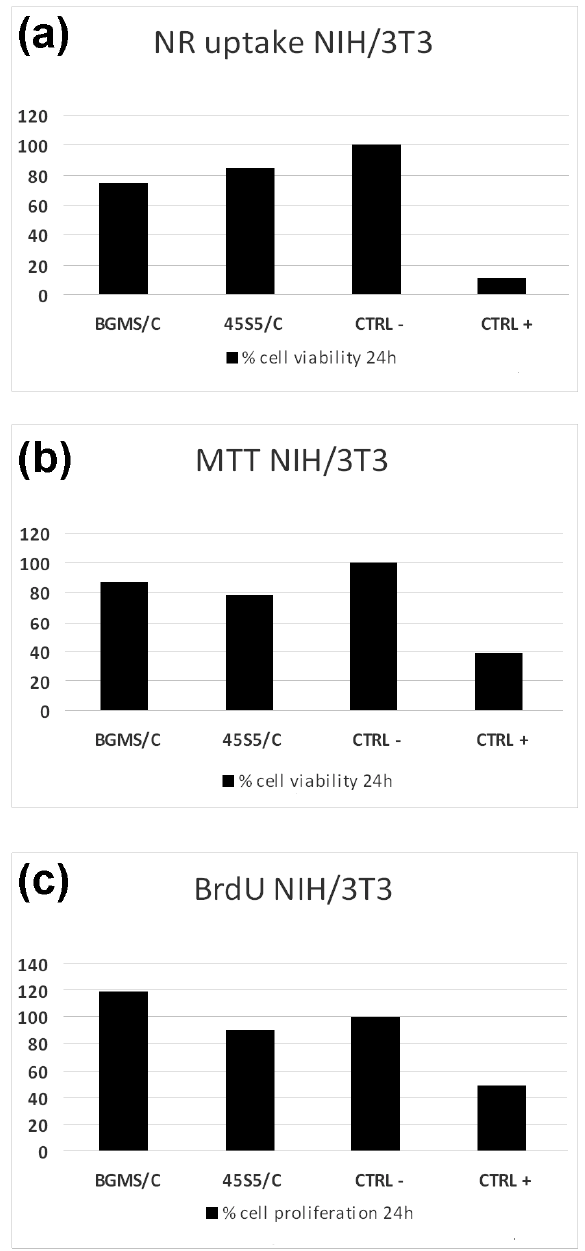
Figure 3. Results of the NR, MTT and BrdU tests for NIH / 3T3 cells after 24 h. ( a ) NR uptake test; ( b ) MTT test; ( c ) BrdU test.